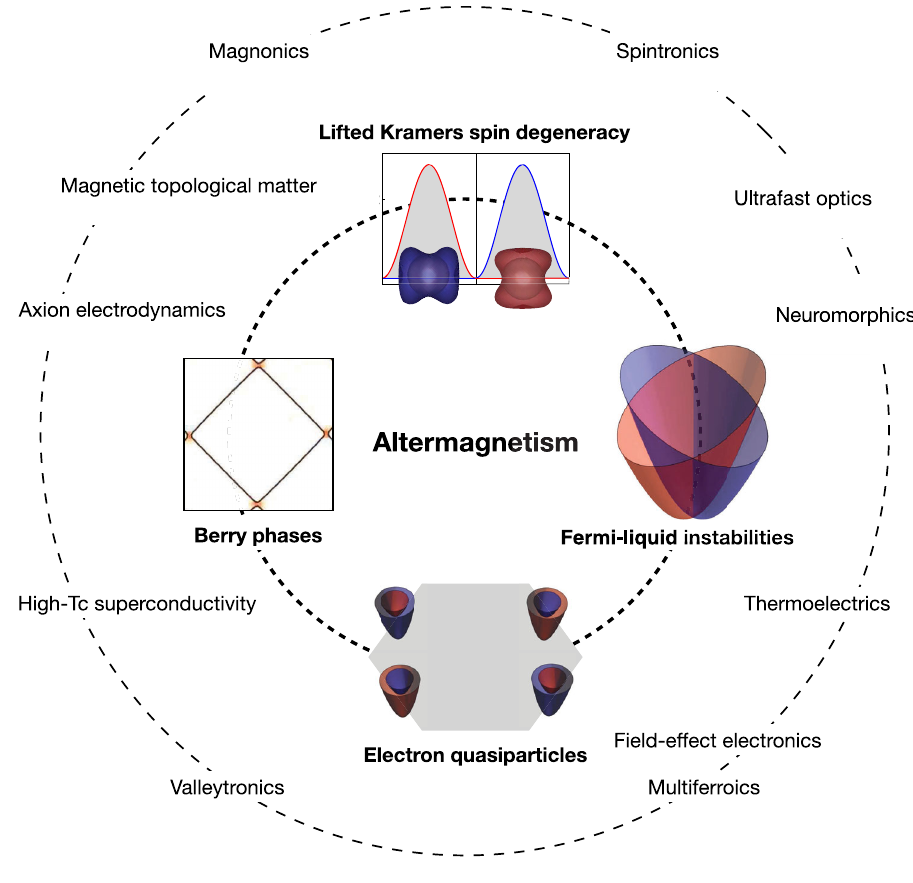
FIG. 14. Summary of the emerging research landscape of